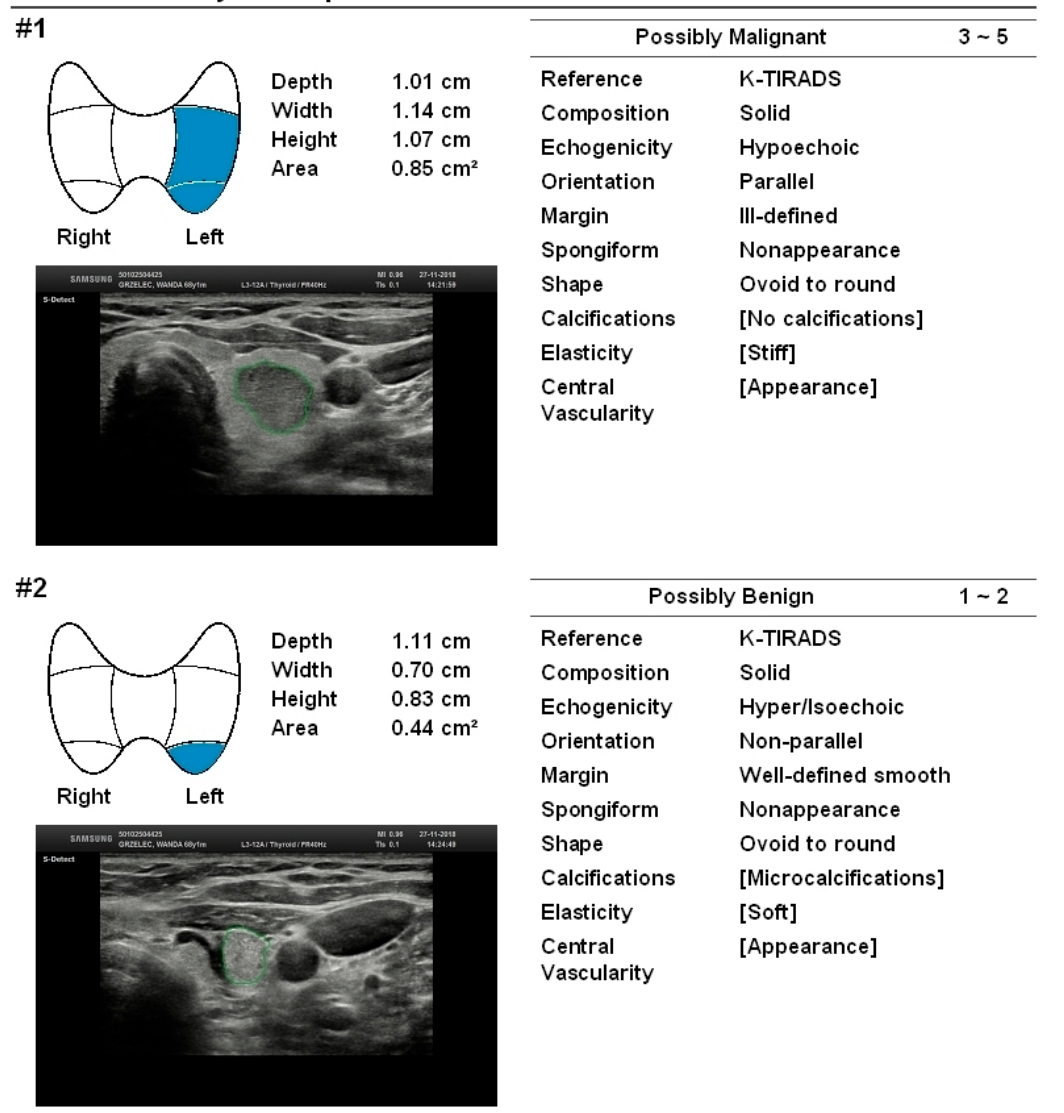
Figure 2. Two lesions diagnosed in one patient. The first lesion obtains 4 points on the EU-TIRADS scale, was diagnosed as “possibly malignant” by S-Detect, and the final histopathological examination revealed the malignant character of the lesion (medullary thyroid cancer). The second lesion, although it may be attributed as suspected due to its taller-than-wide shape was diagnosed as “possibly benign” by S-Detect, whereas it eventually turned out to be a benign hyperplastic nodule. Only features assessed automatically by the device, as the operator-independent ones were taken into consideration in the S-Detect classification. The two last features—elasticity and central vascularity—were not included in the S-Detect prediction. K-TIRADS, Korean Thyroid Imaging Reporting and Data